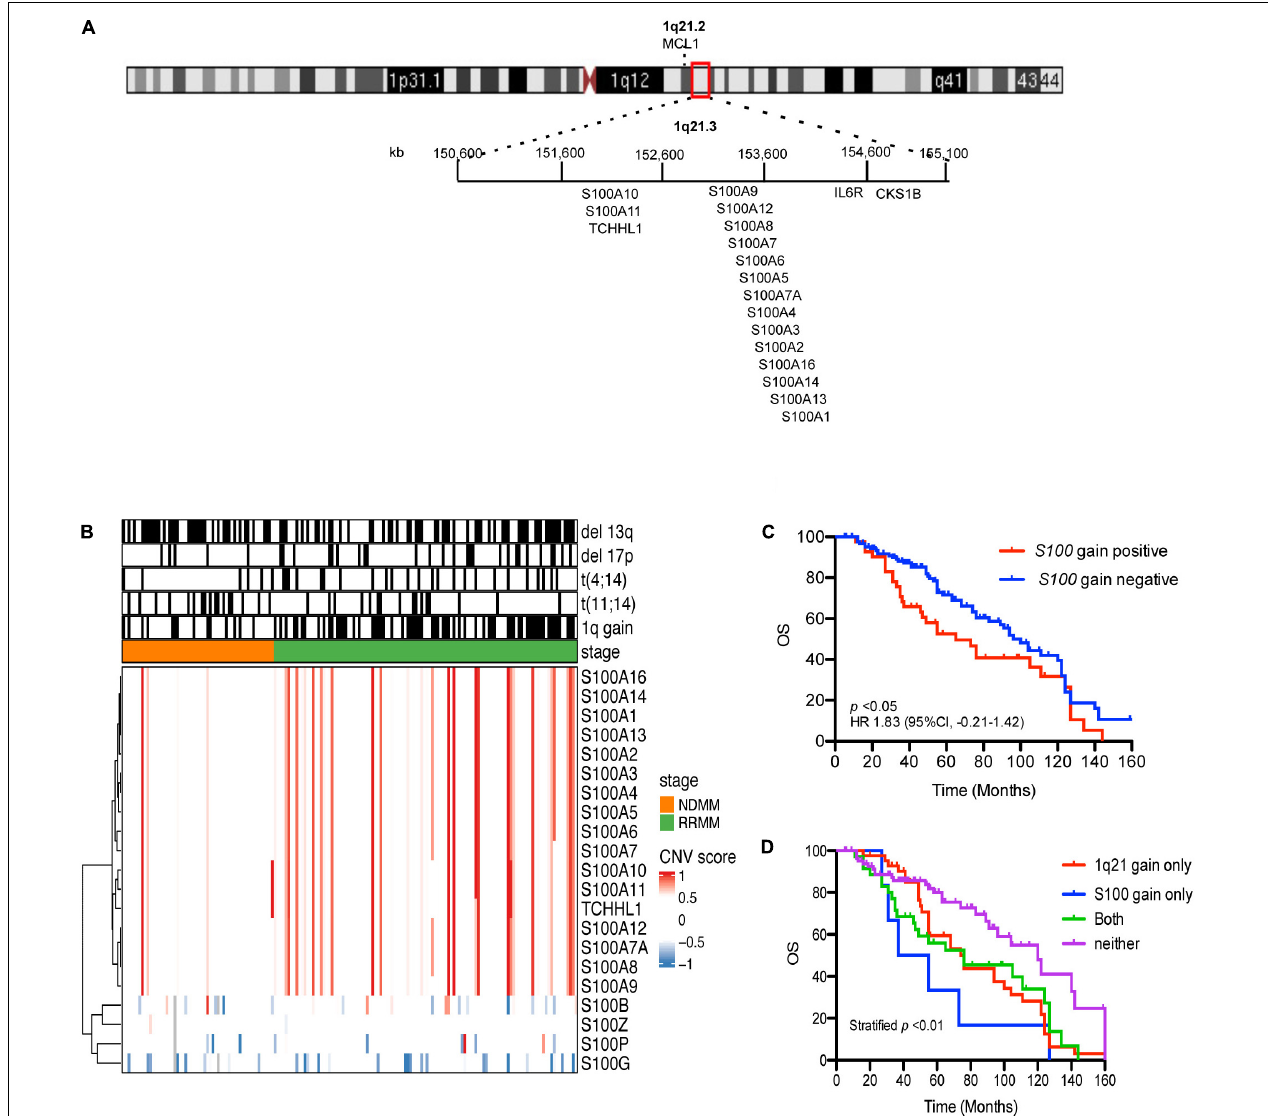
FIGURE 1 | Prevalence and prognostic significance of S100 copy number change. (A) Location of the 17 S100 genes on chromosome 1q21.3. (B) Hierarchical clustering of S100 genes in CD138+ plasma cells from 168 MM patient samples, using Euclidean distance matrix and complete clustering method, based on CNV score. (C) The increased copy number of S100 genes correlated with poor overall survival. (D) Kaplan-Meier curves for MM patients with or without S100 gain. Because patients with S100 gain were also more likely to have 1q21 gain, four groups were used for OS analysis and included: neither 1q21 gain nor S100 gain (Neither), 1q21 gain present but no S100 gain (only 1q21 gain), S100 gain present but no 1q21 gain (only S100 gain), and 1q21 gain and S100 gain present (Both). CNV score > 0.5 indicated a gain event, while < –0.6 is a deletion event. CNV, copy number variation; FIMM, Institute for Molecular Medicine Finland; OS, overall survival; HR, hazard ratio; CI, confidence